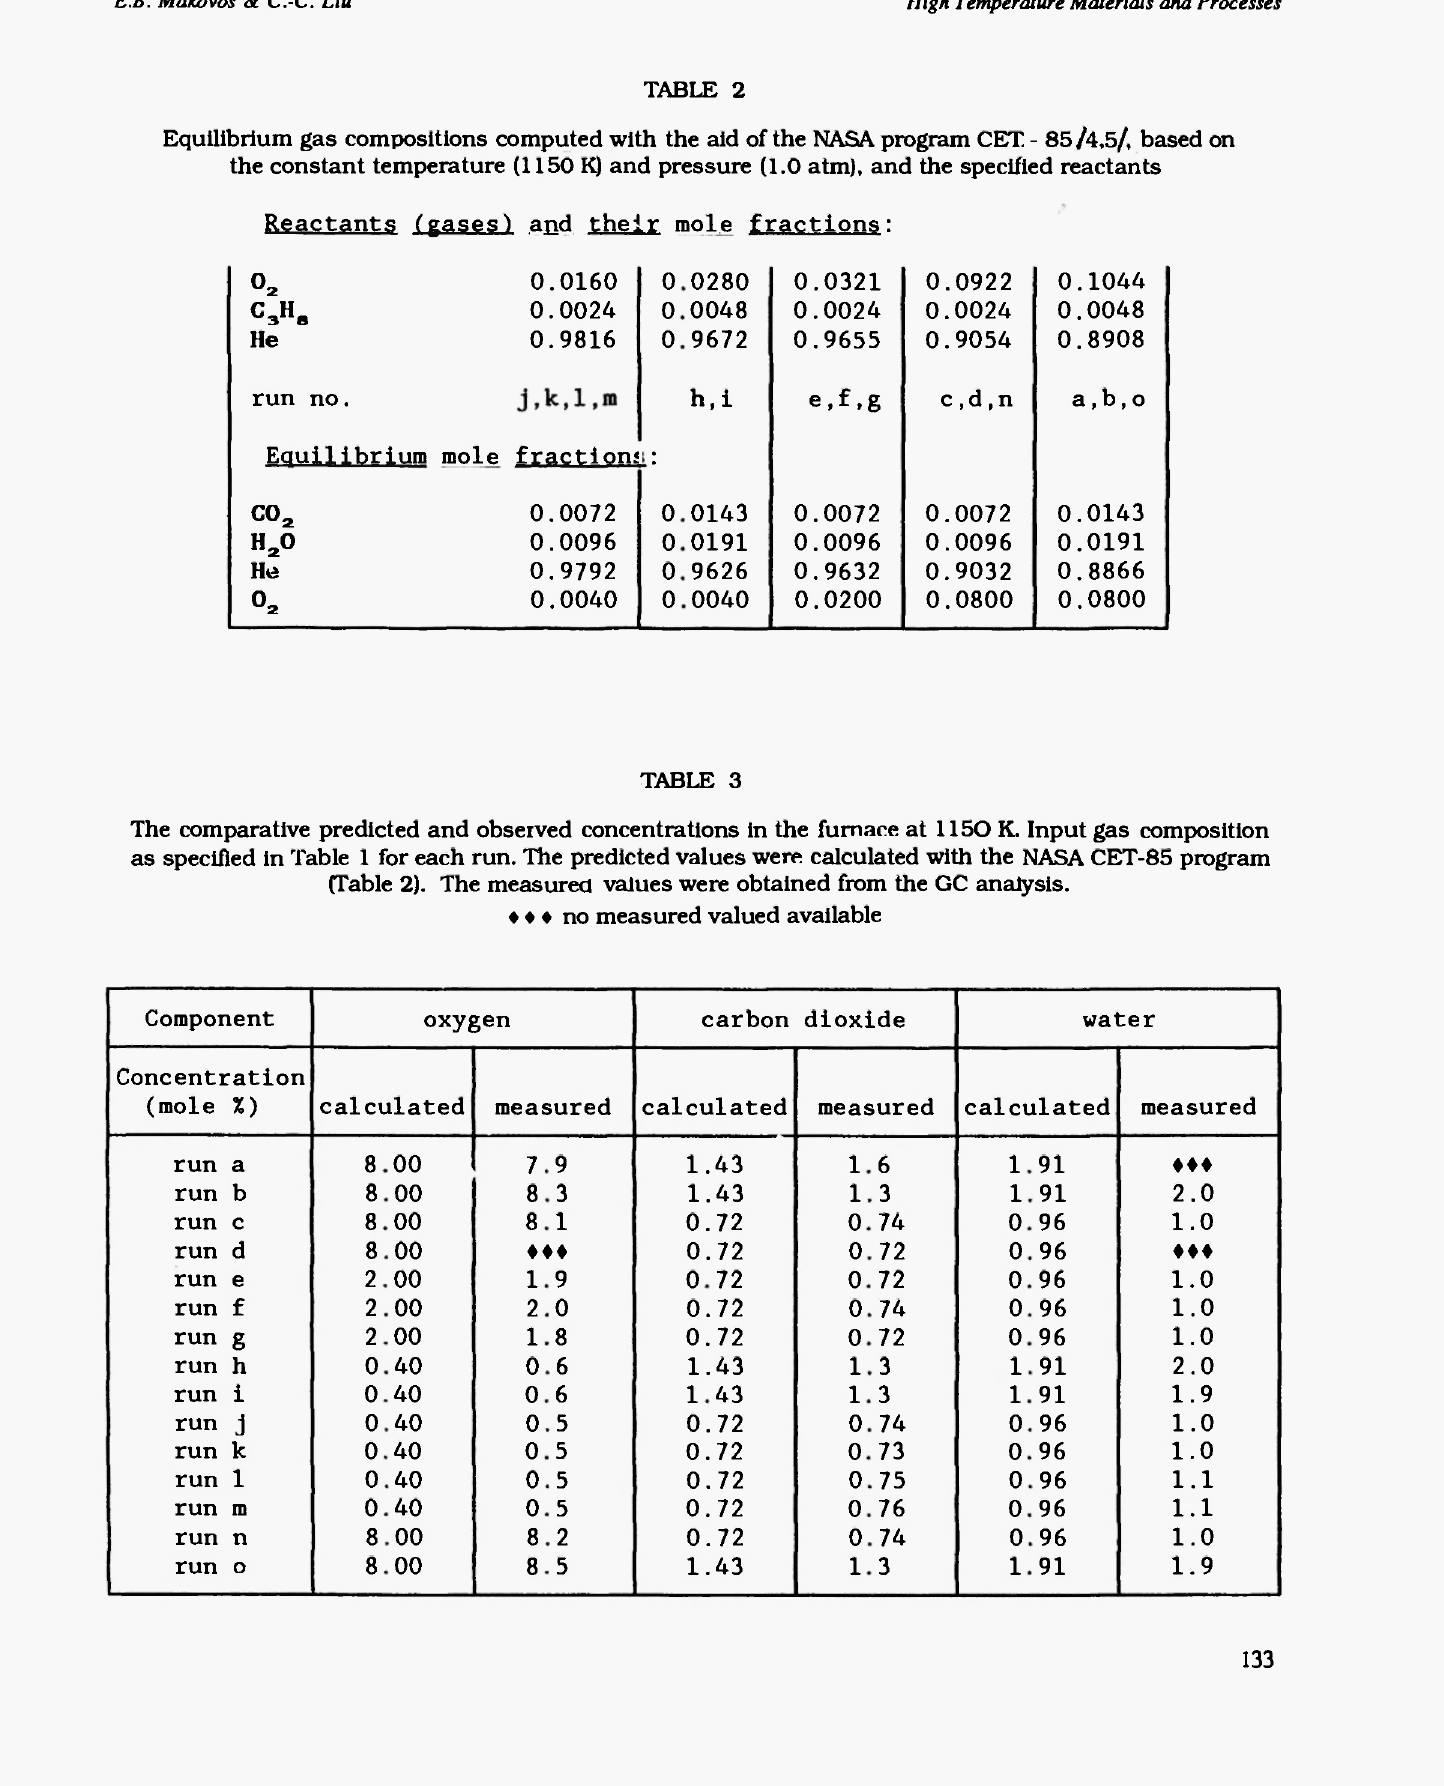
Equilibrium gas compositions computed with the aid of the NASA program CET - 85/4,5/, based on the constant temperature (1150 K) and pressure (1.0 atm), and the specified reactants Rgactants (gggeijs) and their mole fractions: